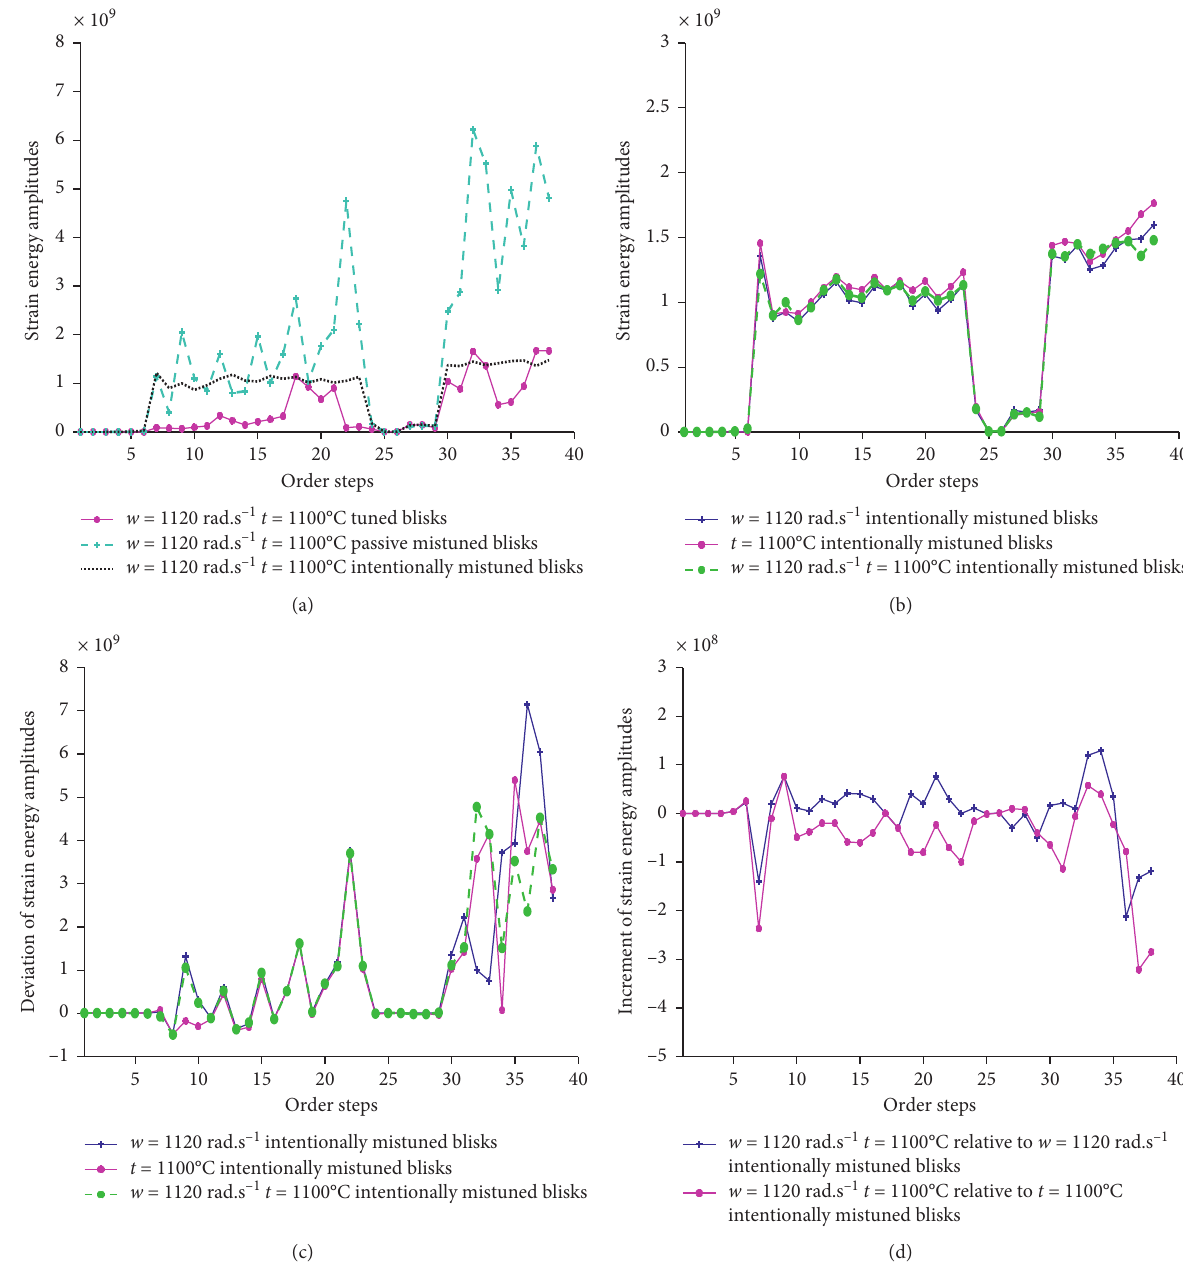
Figure 15: Strain energy amplitudes of intentional MTB. (a) SEAs of tuning, passive, and intentional mistuning. (b) SEAs of intentional mistuning. (c) Deviation of SEAs. (d) Increment of